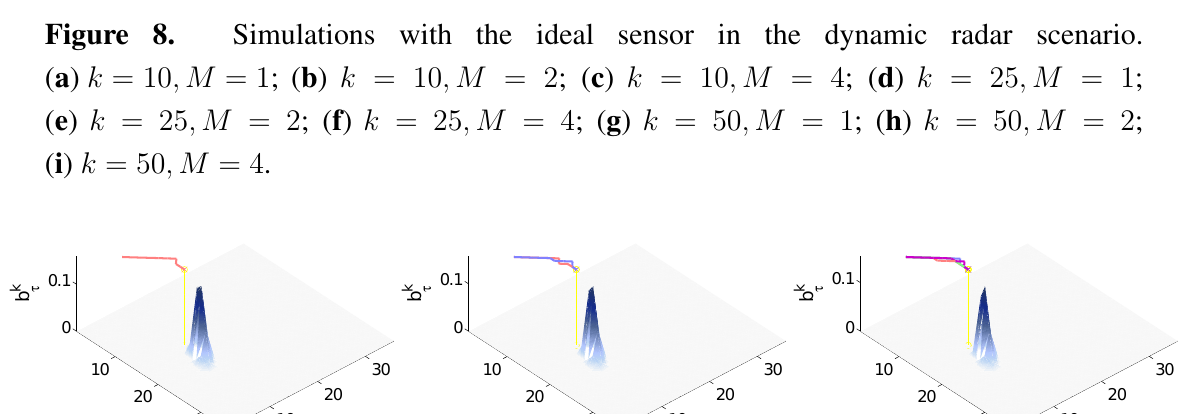
Figure 8. Simulations with the ideal sensor in the dynamic radar